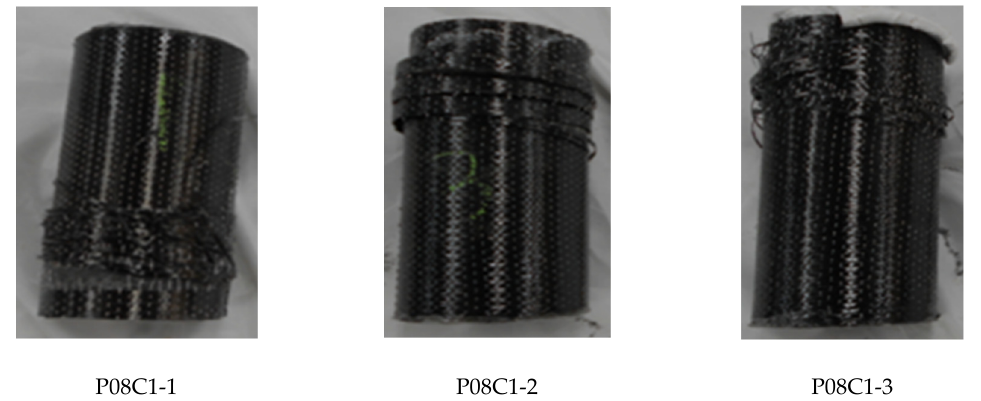
Figure 9. The failure photos of specimens P08C1.